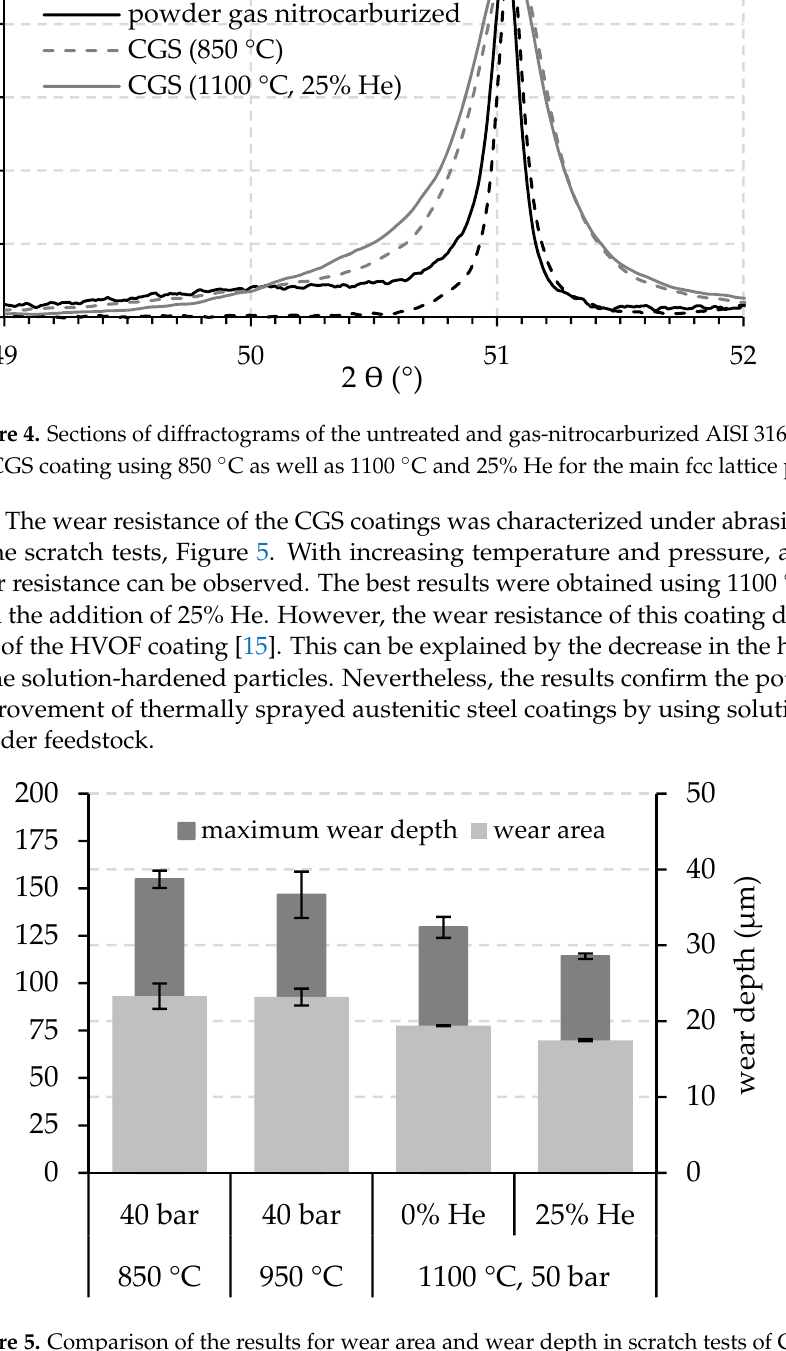
Figure 5. Comparison of the results for wear area and wear depth in scratch tests of CGS coatings in dependence of the process parameters.